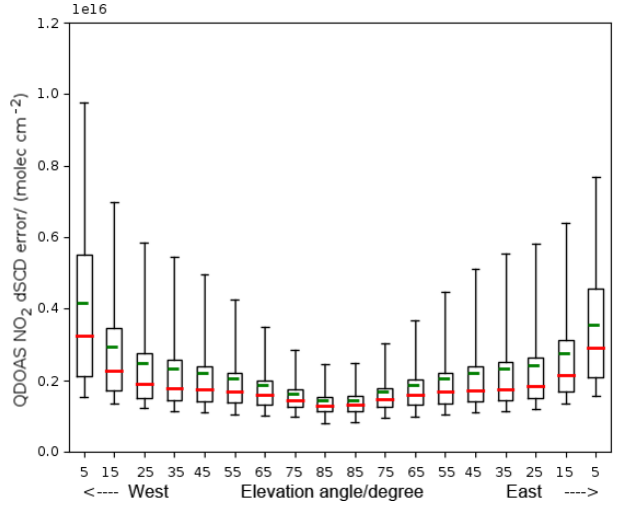
Figure 2. The dSCD measurement error statistics for NO 2 at the UNAM station as a function of elevation angle for data taken in the year 2016. The box encloses the 25–75th percentiles, the whiskers are 5%–95%, and the green bar is the mean and the red bar the